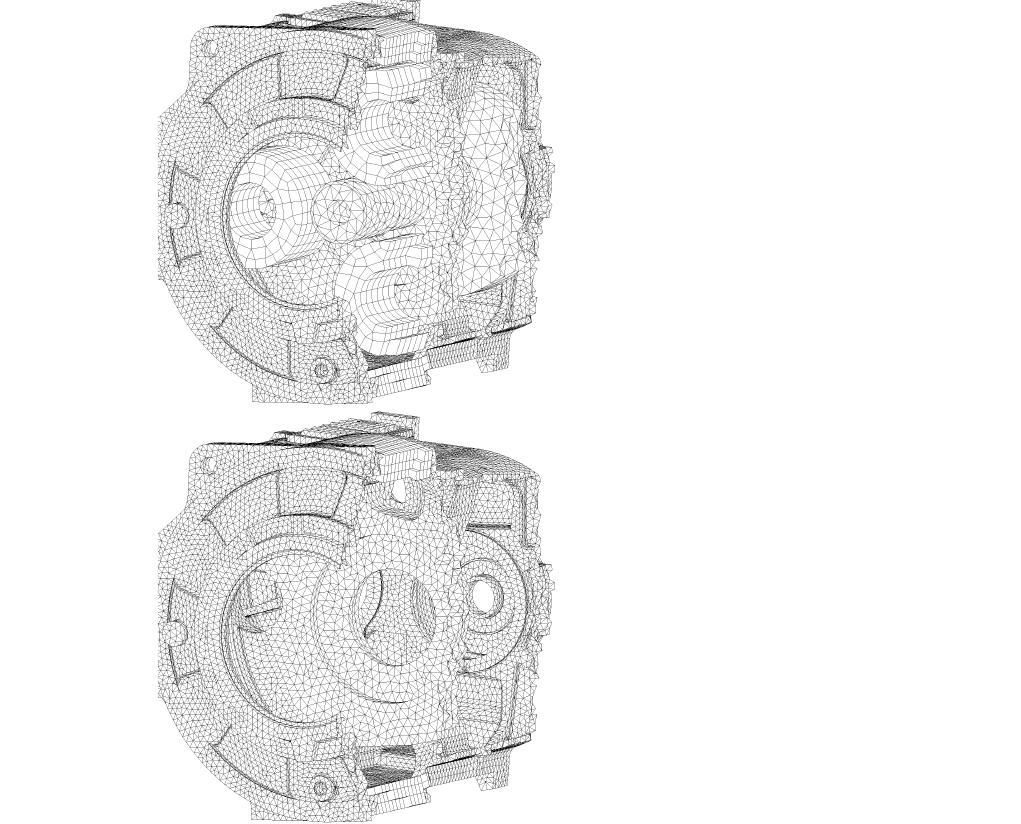
Figure 24. Calculation of the response of the housing to a unit bearing force with (top) and without (bottom) consideration of internal components.